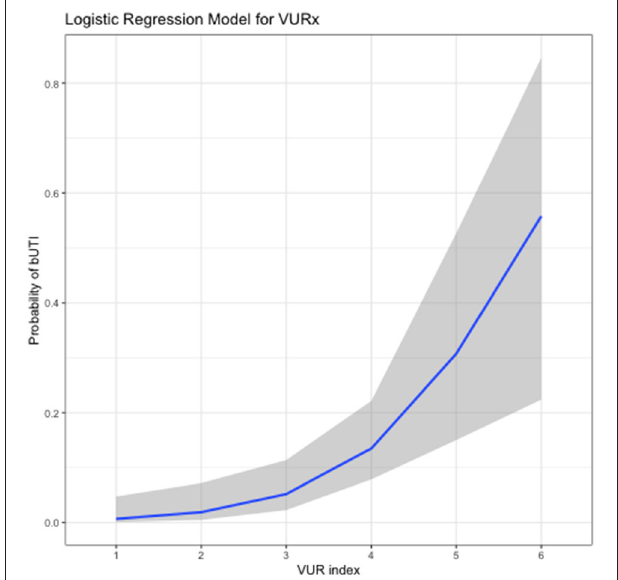
FIGURE 1 | Relationship between vesicoureteral reflux index (VURx) score and subsequent occurrence of breakthrough urinary tract infections (bUTIs) ( 63). The graph is based on data from a cohort of 139 patients, mean age at VUR diagnosis 5.45 years (standard deviation, 4.7 years), followed for a mean of 32.1 months (standard deviation, 24.5 months) after diagnosis. Reproduced with permission purchased from the Copyright Clearance